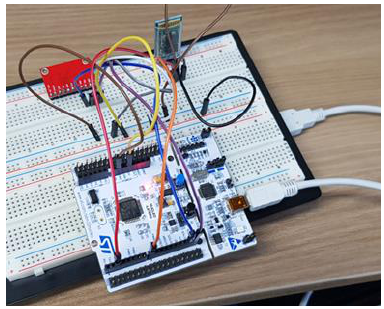
Figure 6. Embedded hardware construction based on the development modules for indoor positioning system.